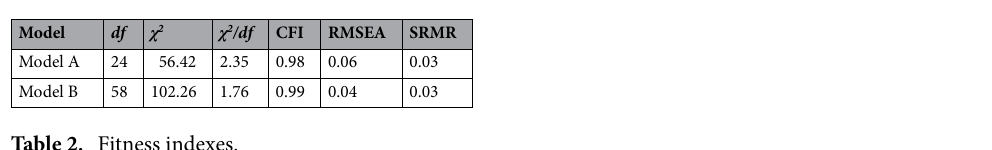
Table 2. Fitness